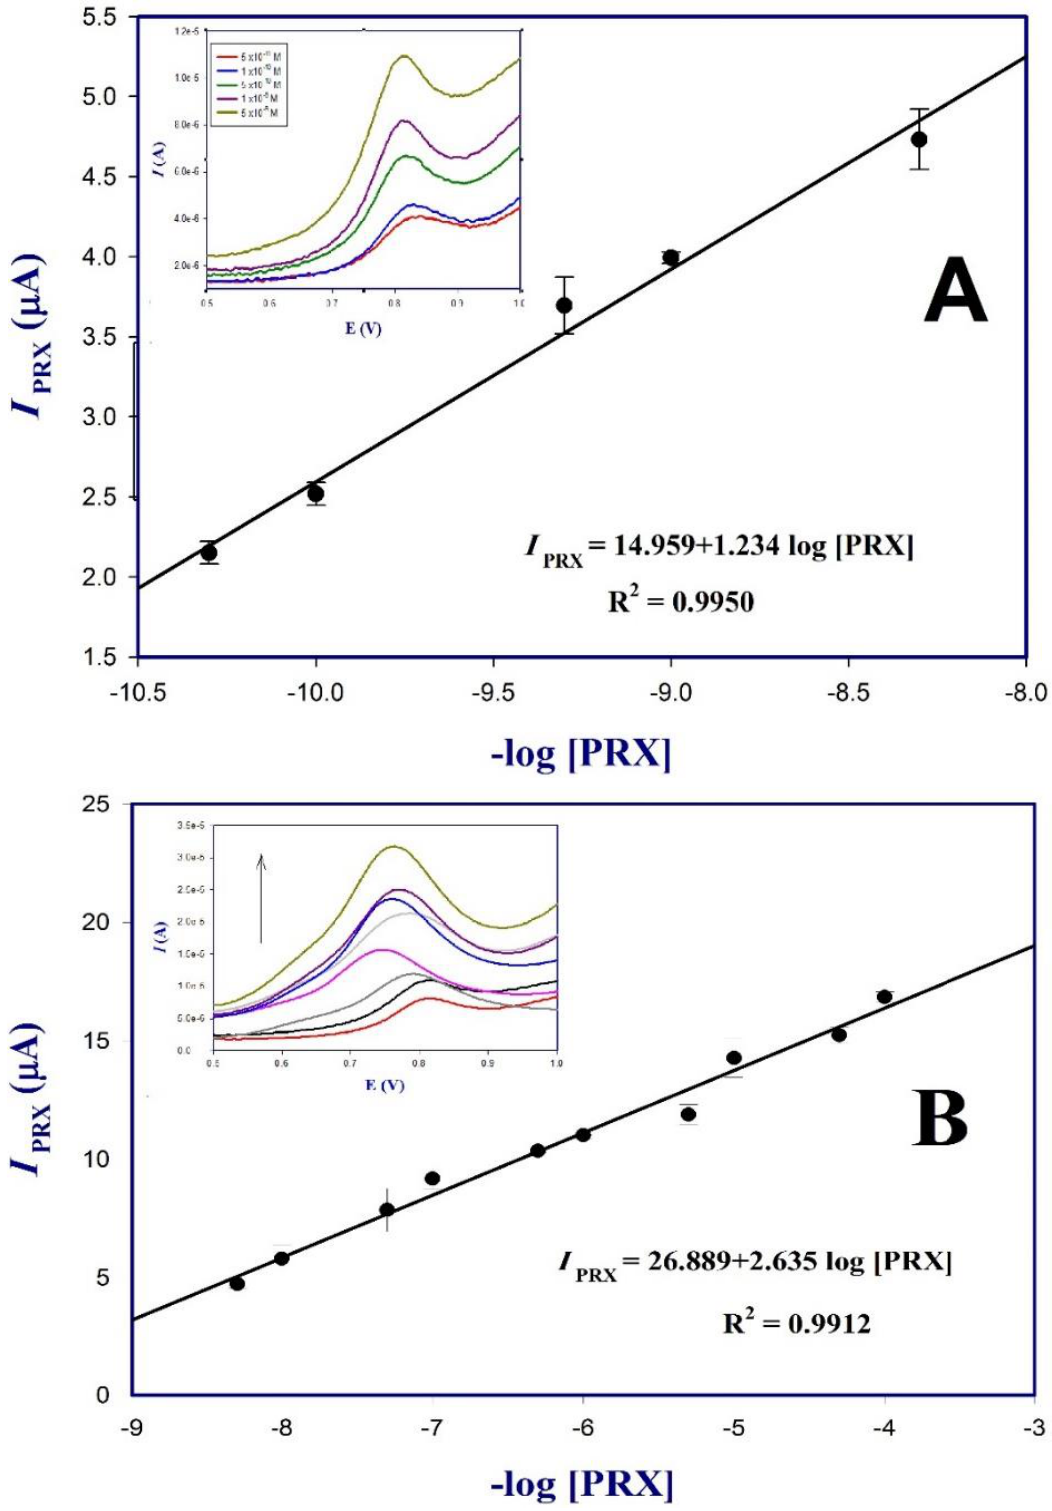
Figure 6. Calibration graph for PRX on the surface of poly ( DL -met)/AuNPs-GCE for concentrations ( A ) 5 × 10 − 11 to 1 × 10 −4 M and ( B ) 5 × 10 −8 to 1 × 10 −4 M at optimum conditions (inset: DPV of the tested concentrations). Table 1. Comparison between the present work and other previously reported electrochemical methods for PRX detection.